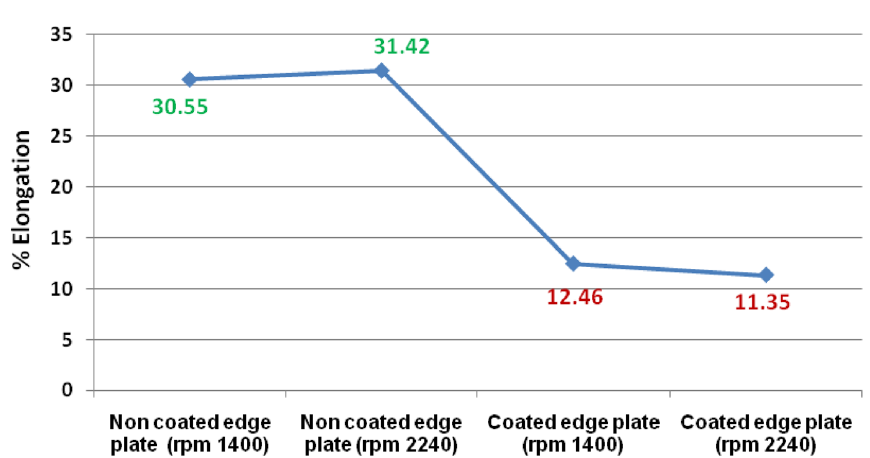
Figure 12. The % Elongation of welded joints at varying